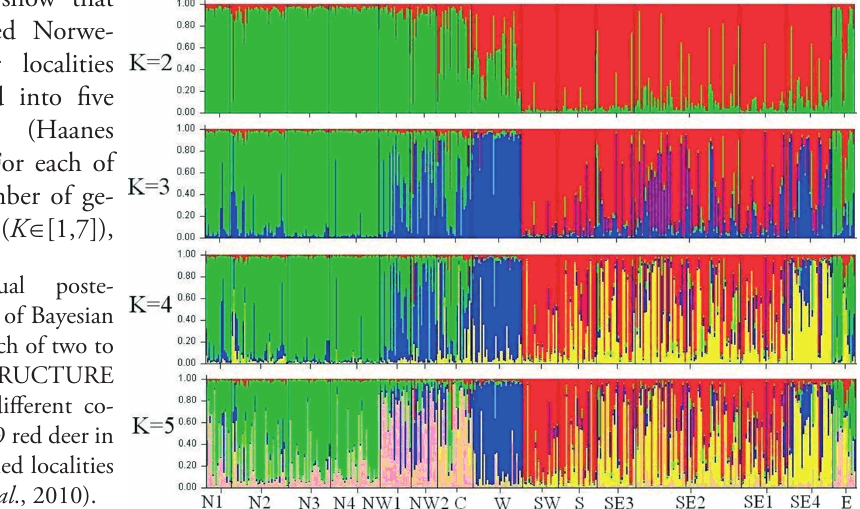
Individual poste- rior probabilities of Bayesian assignment to each of two to five clusters (STRUCTURE with K ∈ [2,5], different co- lours) among 419 red deer in each of 15 sampled localities (from Haanes et al ., 2010).